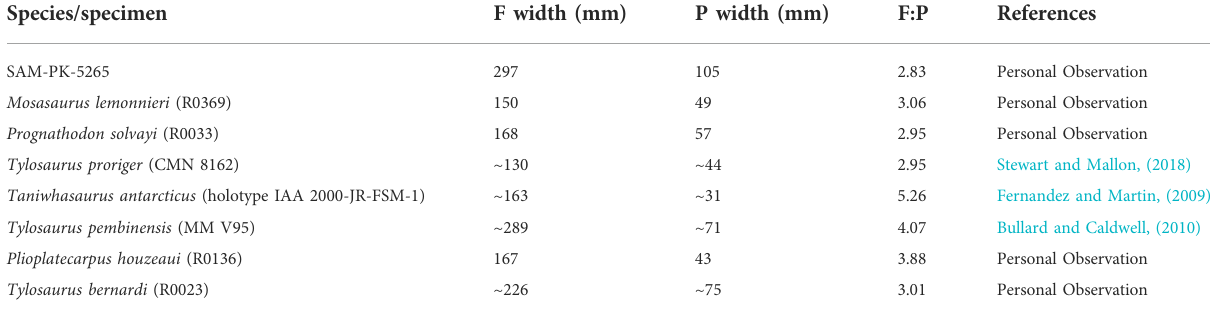
TABLE2Theratiosoffrontal(F)toparietaltable(P)widthofthedifferentmosasaurtaxaincludingSAM-PK-5265.MeasurementsweretakenatRBINS and from publications cited. The frontal width was measured between the posterolateral edges of the frontal and the parietal width was measured across the posterior-most section of the parietal bar.